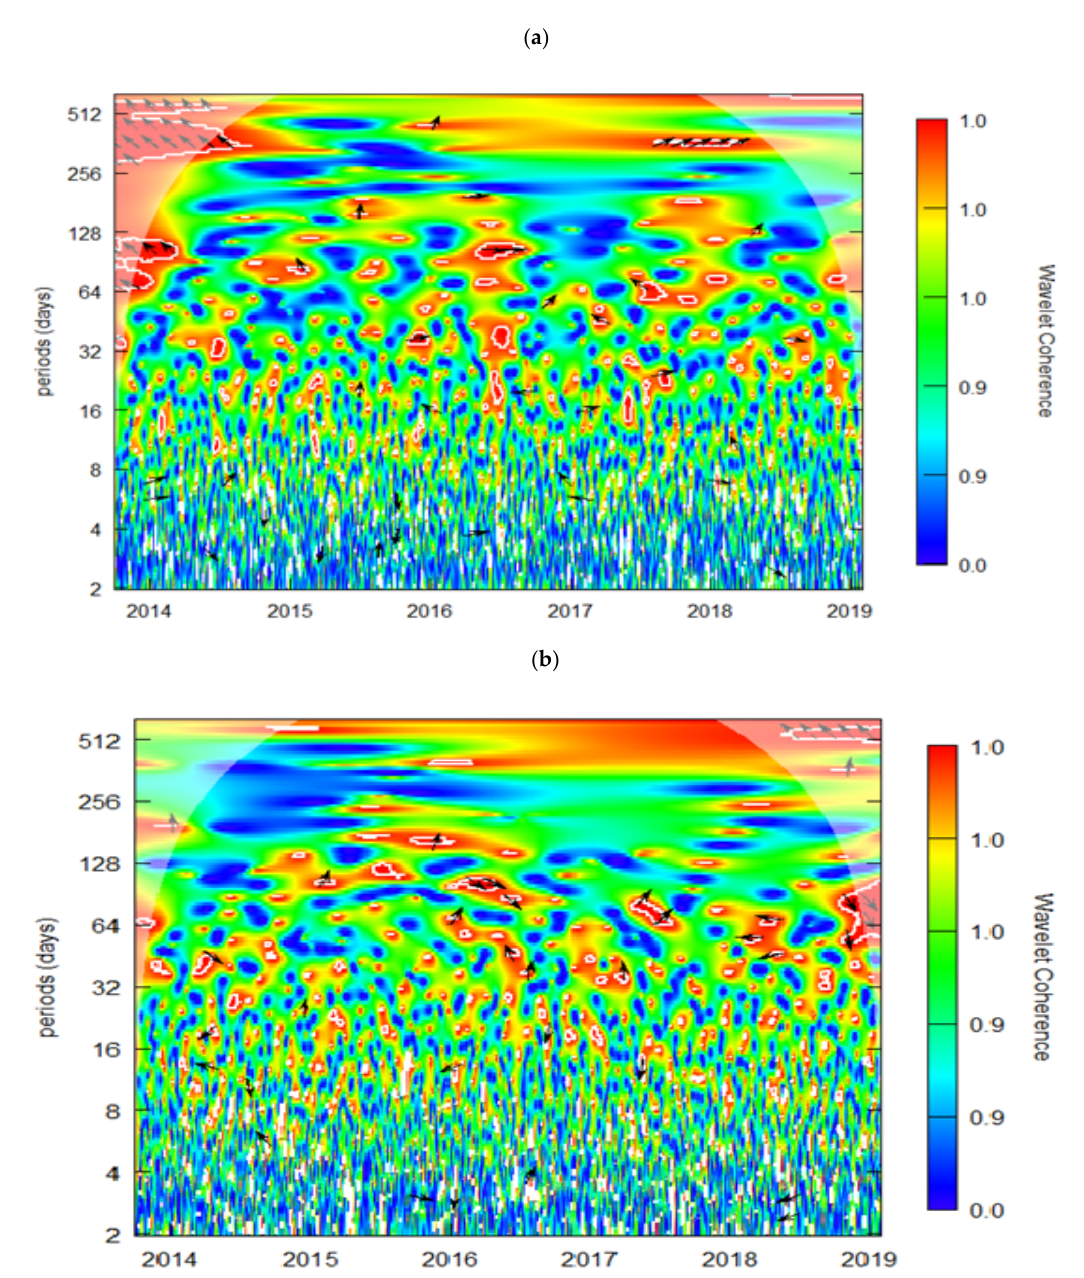
Figure 3. Wavelet coherence. ( a ) BTC vs. USA-EPU. ( b ) BTC vs. CHN-EPU. Notes: (i) BTC = Bitcoin; CHN_EPU = Chinese economic policy uncertainty index; USA_EPU = USA economic policy uncertainty index. (ii) The plots show the estimated wavelet coherence for pairs of Bitcoin and the EPU. Lower scales are associated with the long-term investment horizon, whereas higher scales are associated with the short-term investment horizon. The horizontal axis shows the time; the leftmost reflects the start of the data interval and the rightmost reflects the end of the data interval. Warm colors such as red represent high coherence (or correlation) and cold colors such as blue represent low coherence. A thick black line represents statistically significant areas of coherence. The direction of the black arrows displays two things: the sign of correlation and the lead–lag phase relations between the two series.